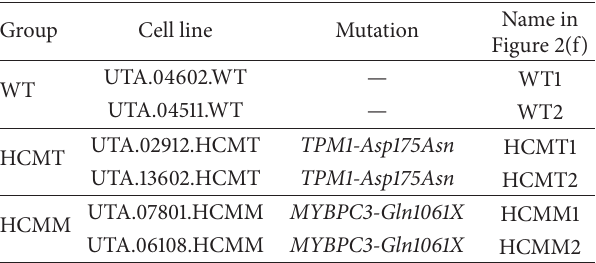
Table2:ThehiPSClinesandtheirmutationsandabbreviationsused in the